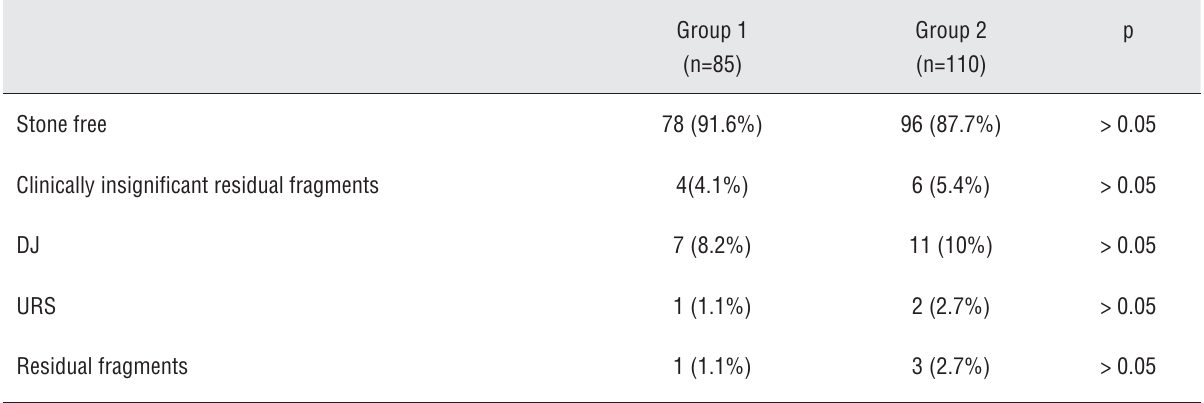
Table 3 - Success rates of both